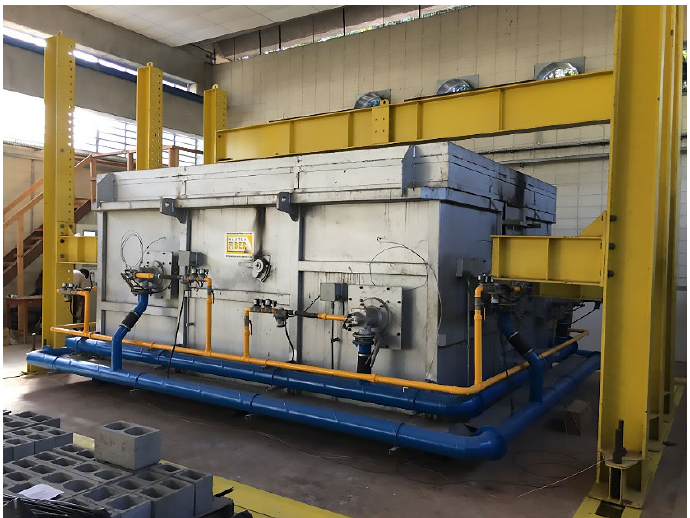
Figure 4. External view of the furnace used in the